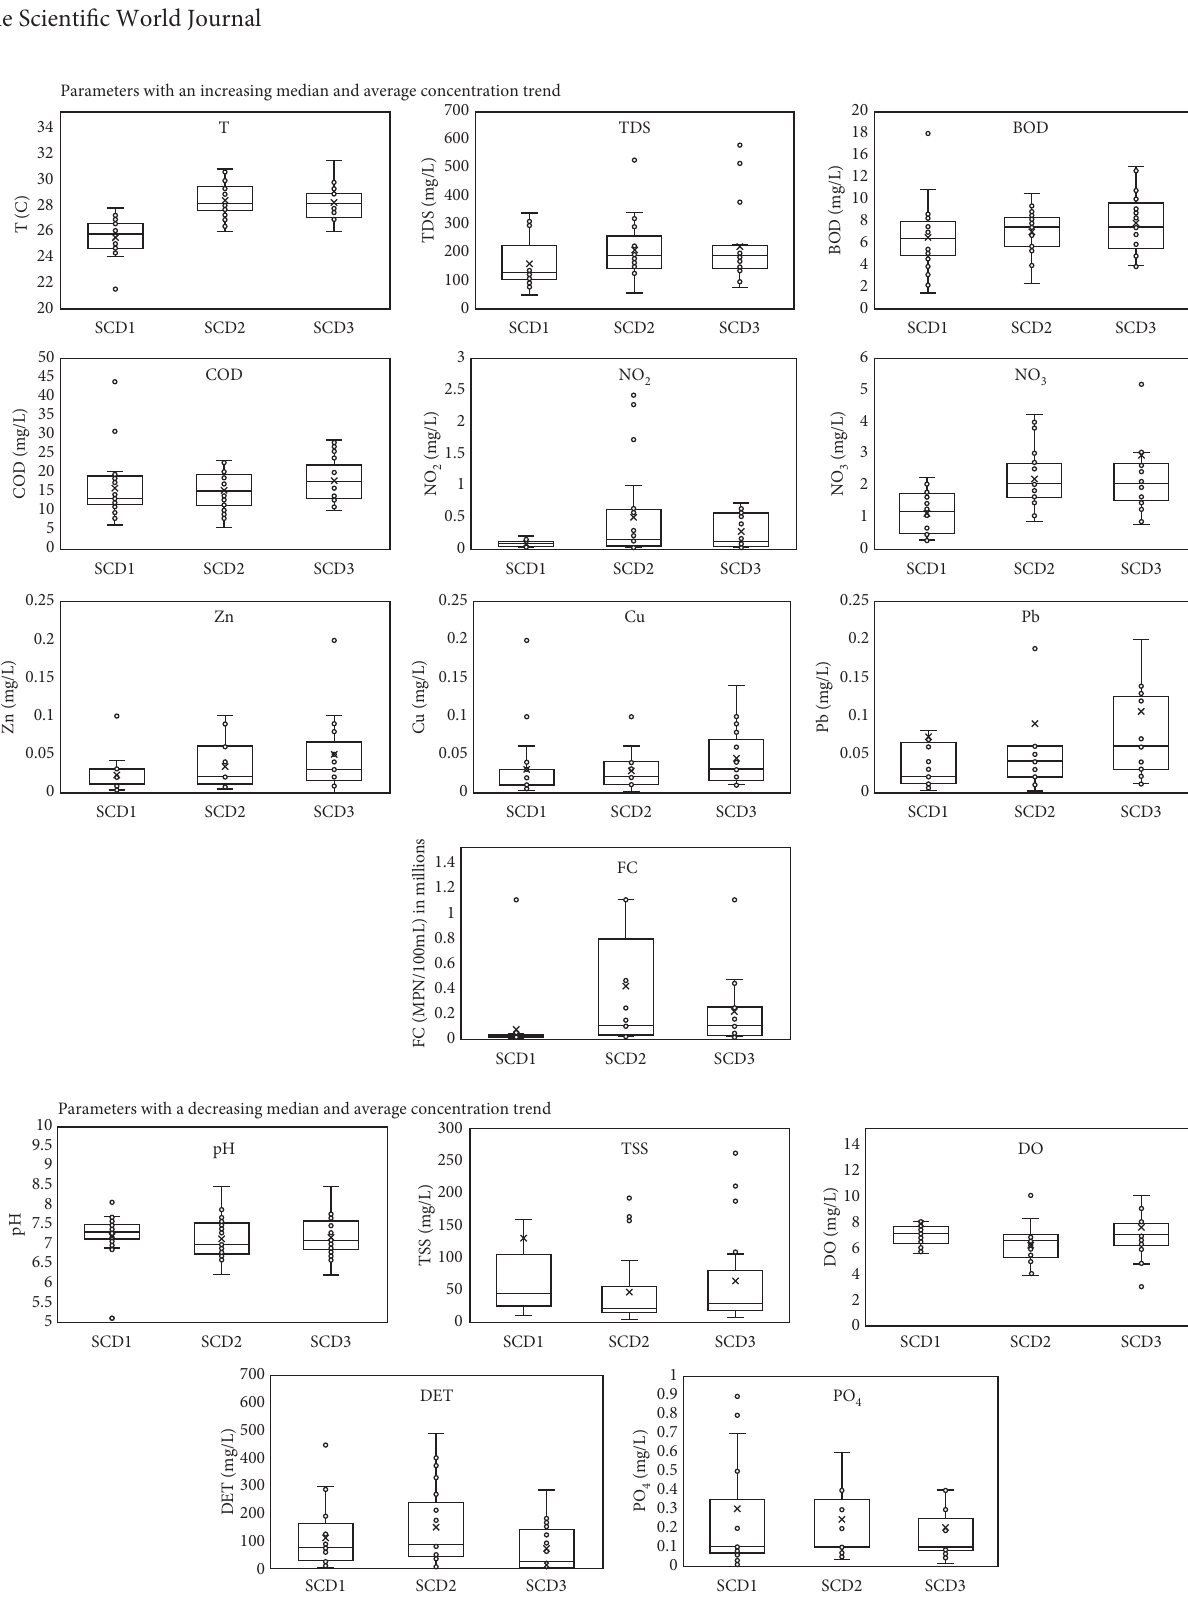
Figure 2: The spatial trend of water quality in Code